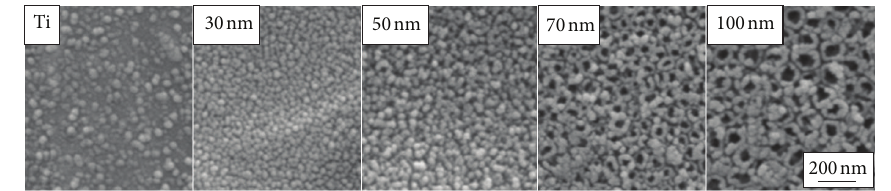
Figure 5: SEM micrographs showing protein adsorption on the surfaces of flat Ti and 30, 50, 70, and 100 nm diameter TiO 2 nanotubes after 2h of incubation in growth medium.